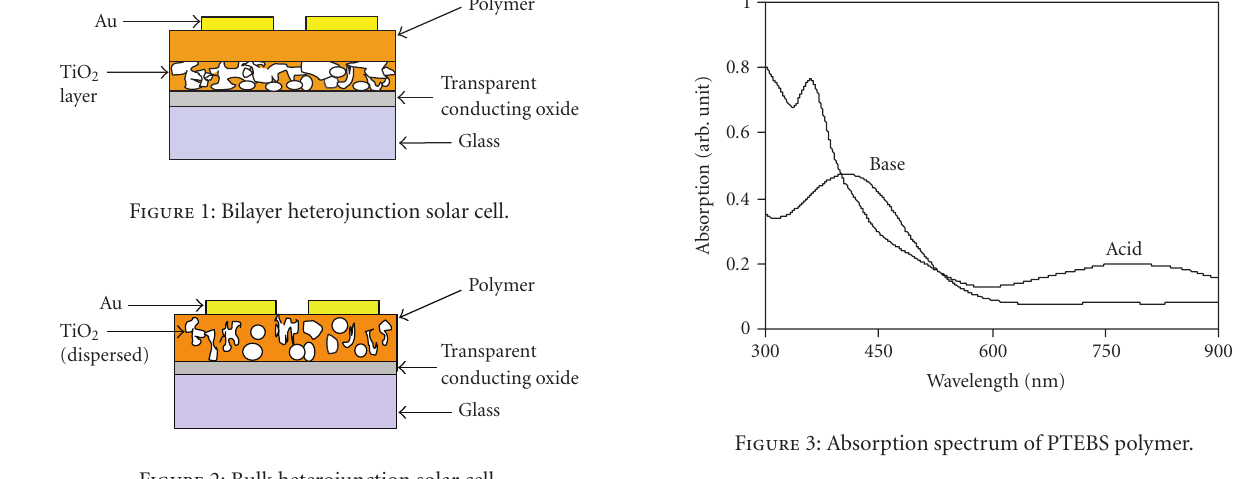
Thin films of PTEBS made from HCl and basic solutions were also investigated. The films have an appearance